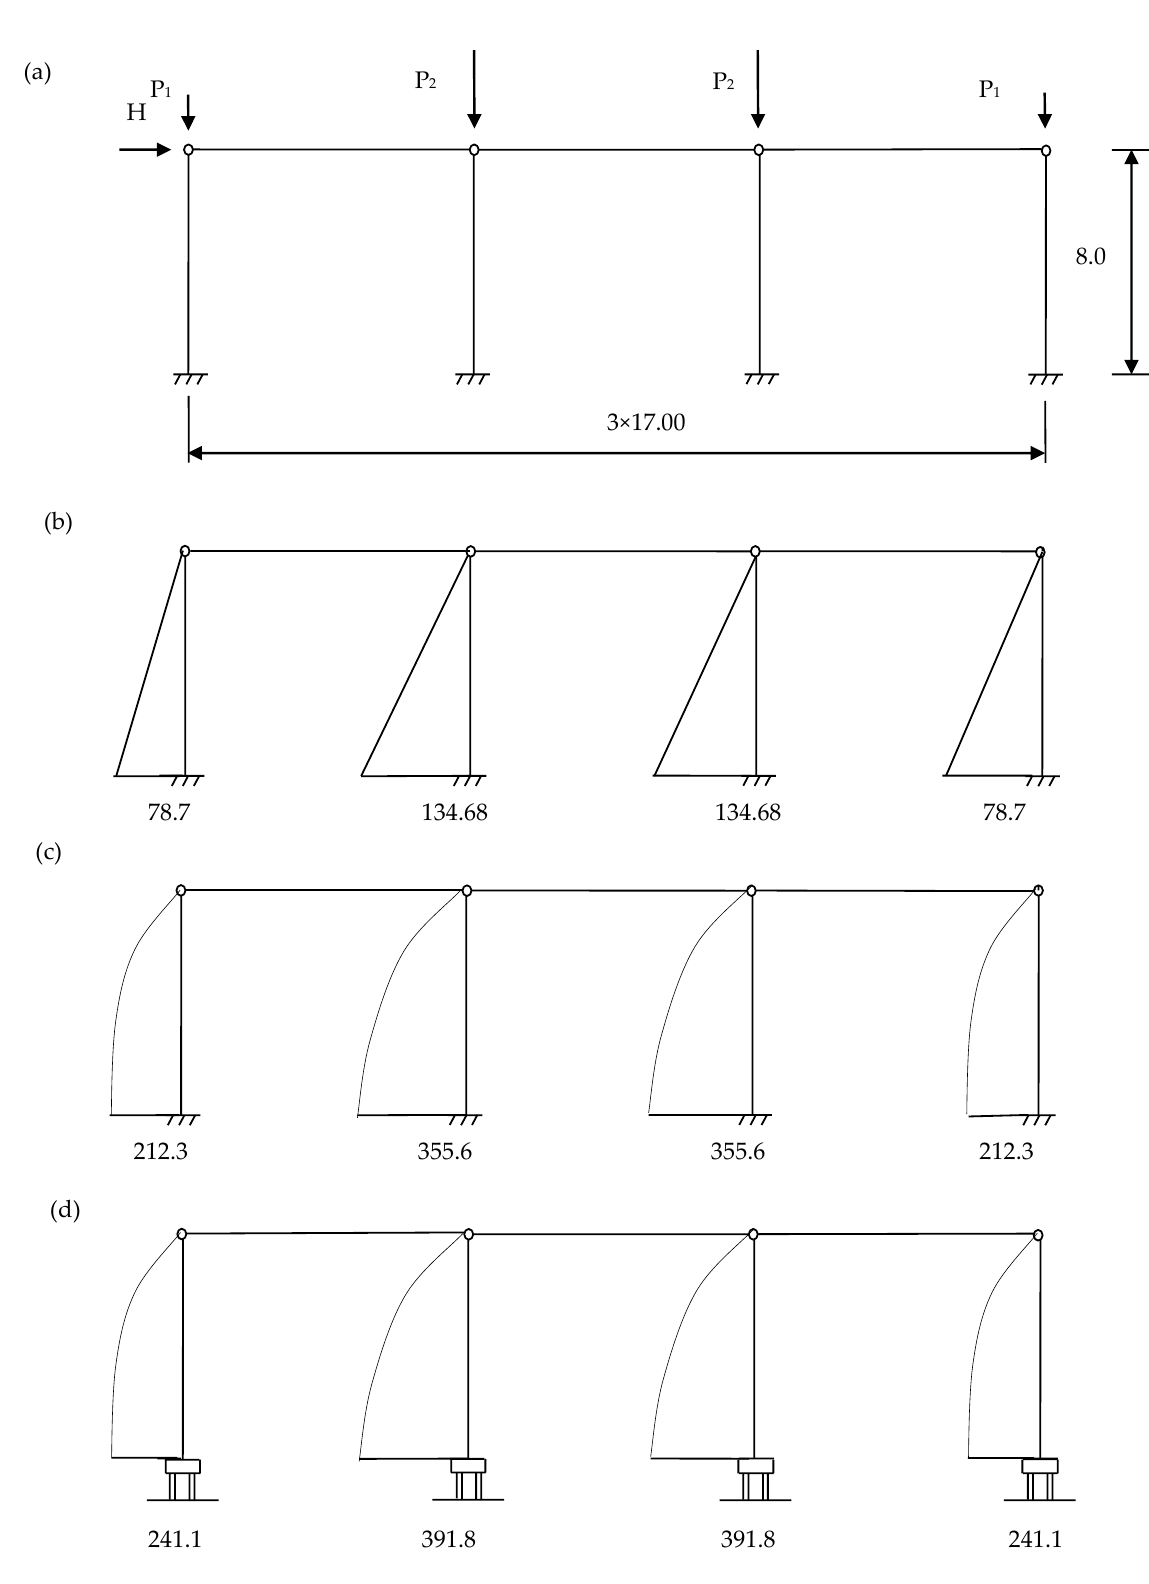
Figure 10. ( a ) Diagram of the frame in Example 1, ( b – d ) bending moments in the columns [kNm] according to the first-order theory and the second-order theory in the case of full restraint and pile foundation,